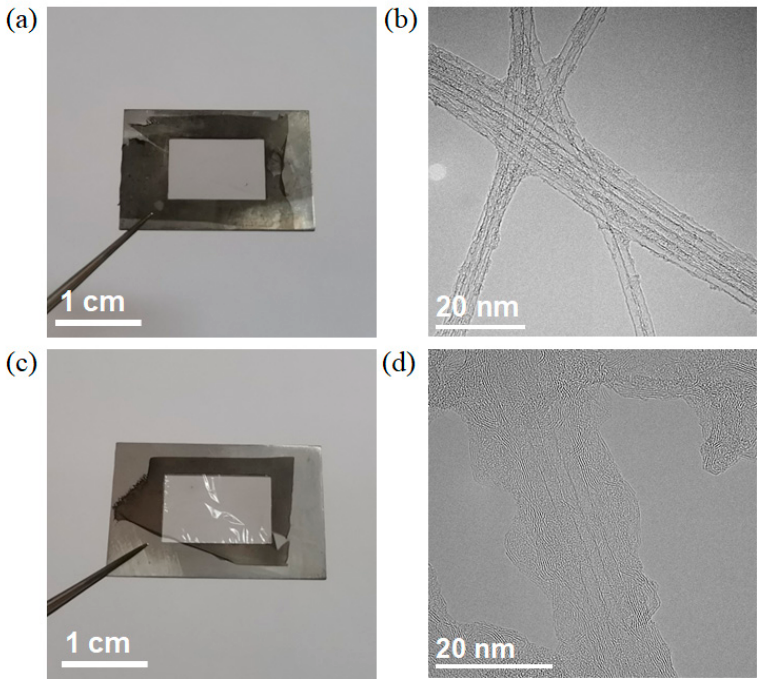
Figure 1. ( a , c ) Optical and ( b , d ) TEM images of a SWCNT film ( a , b ) before and ( c , d ) after CVD growth of h-BN.